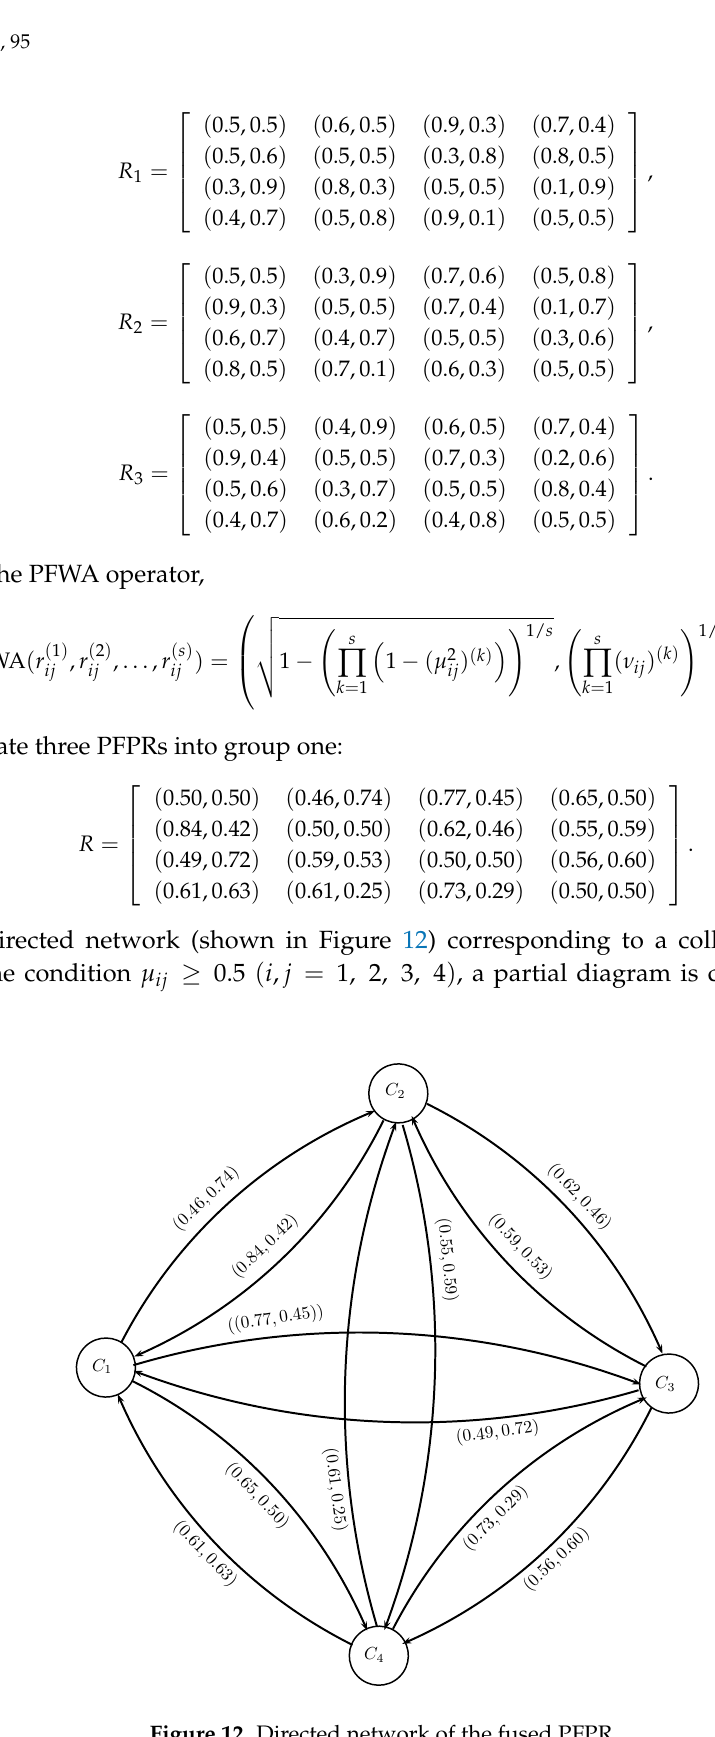
Figure 12. Directed network of the fused